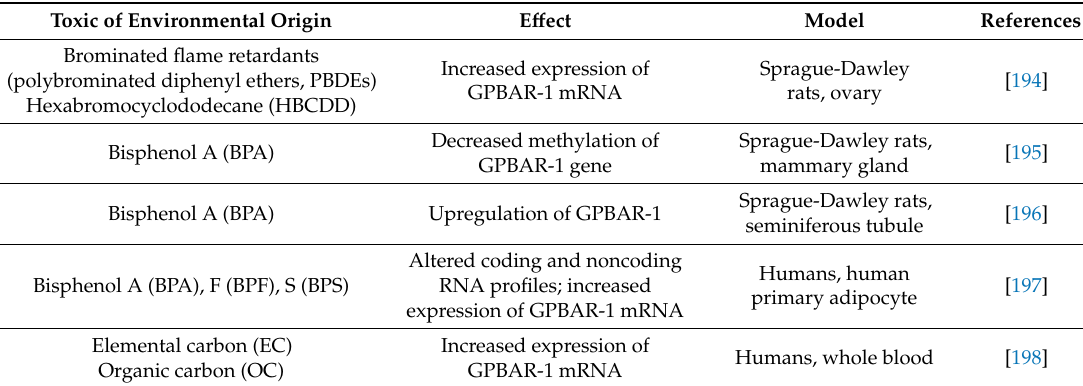
Table 5. Toxic products of environmental origin influencing GPBAR-1 gene